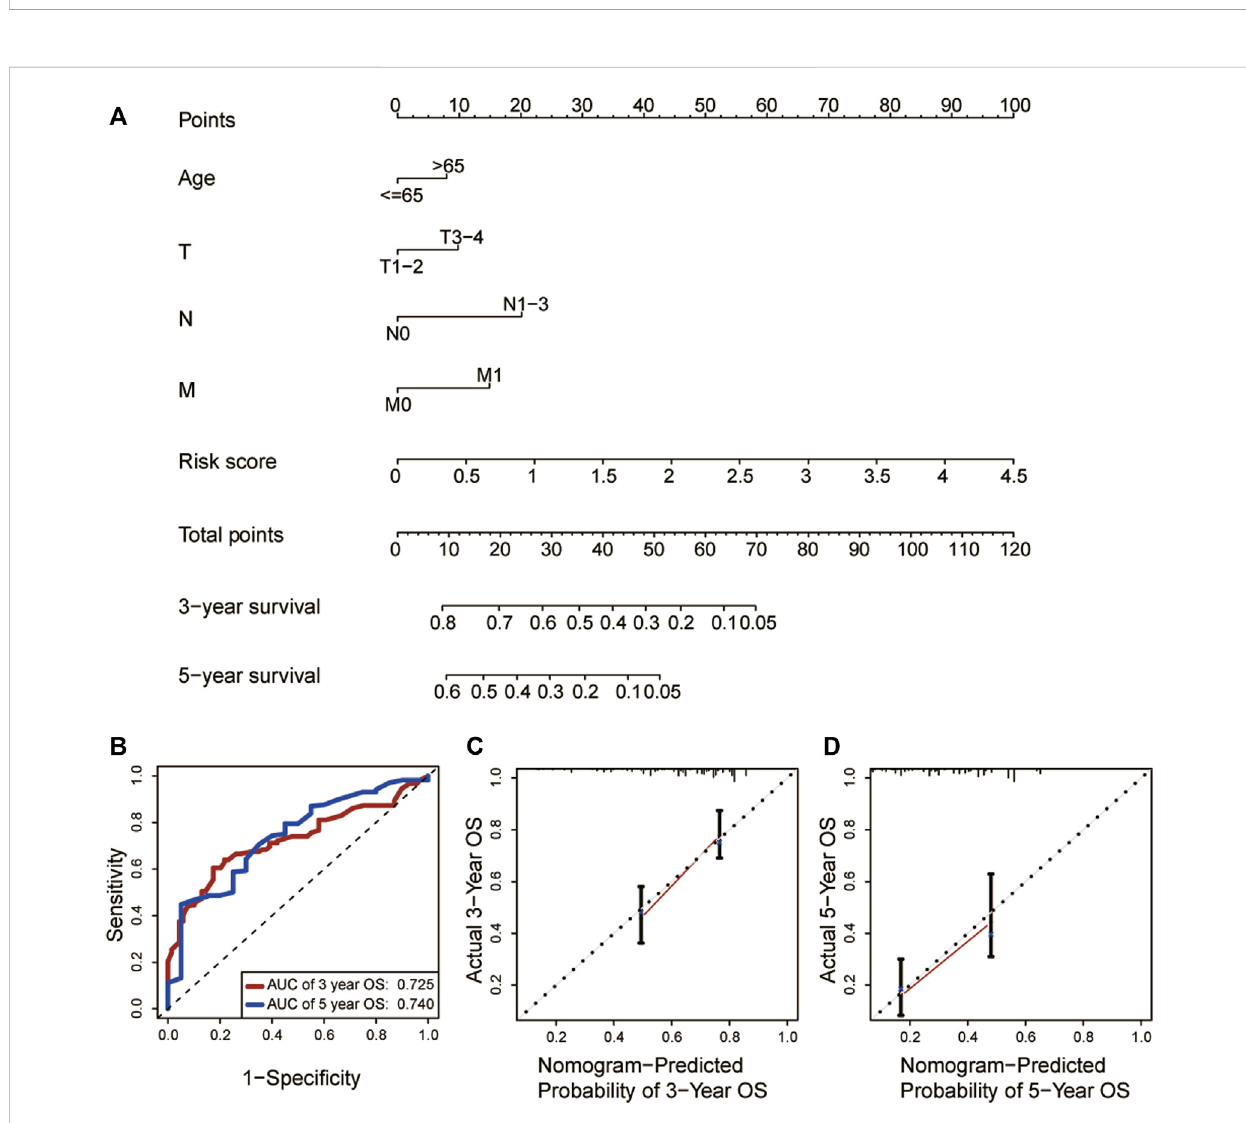
FIGURE 6 Constructionandassessmentofthenomogram( n =453). (A) Establishmentofthenomogram. (B) AccordingtoROCcurveanalysisforpredictingOS by the nomogram, the AUCs for 3-year OS was 0.725 and that for 3-year OS 0.740. (C, D) The calibration curve for nomogram ’ s 3-year and 5-year OS, respectively. ROC: Receiver operating characteristic; OS: Overall survival; AUC: Area under